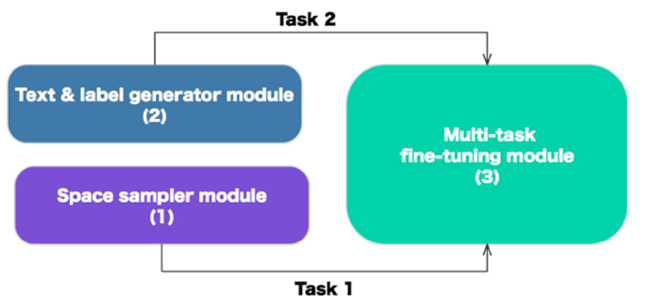
Figure 5. Architecture of our cross-modal multi-task fine-tuning representation learning framework.